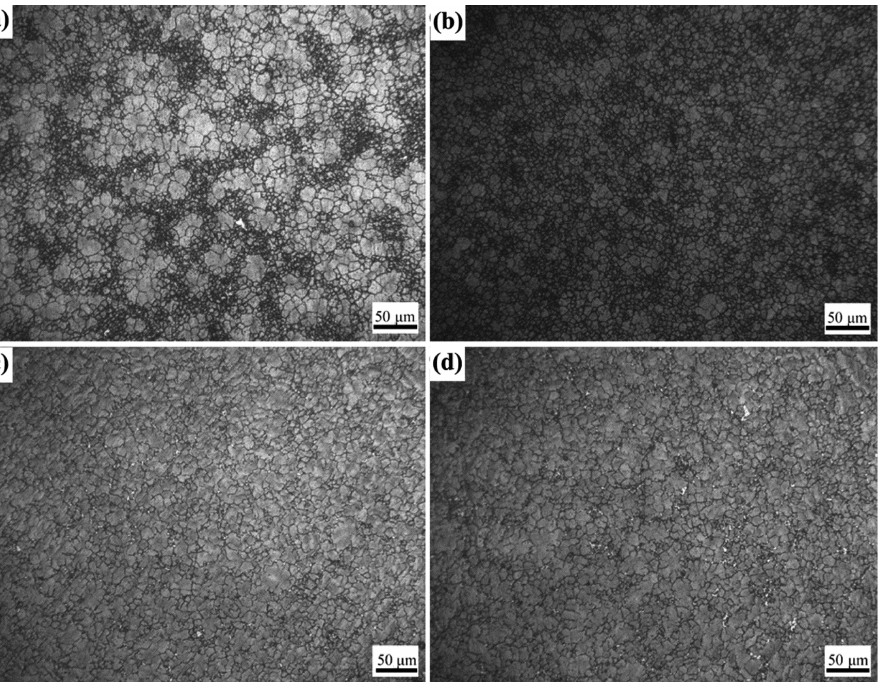
Figure 4: Optical micrographs of the as-extruded AZ80 – 2Sn alloys with different Bi additions: (a) 0 mass %Bi; (b) 0.5 mass %Bi; (c) 1 mass %Bi; (d) 1.5 mass